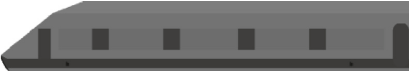
Figure 2: Model of a high-speed railway